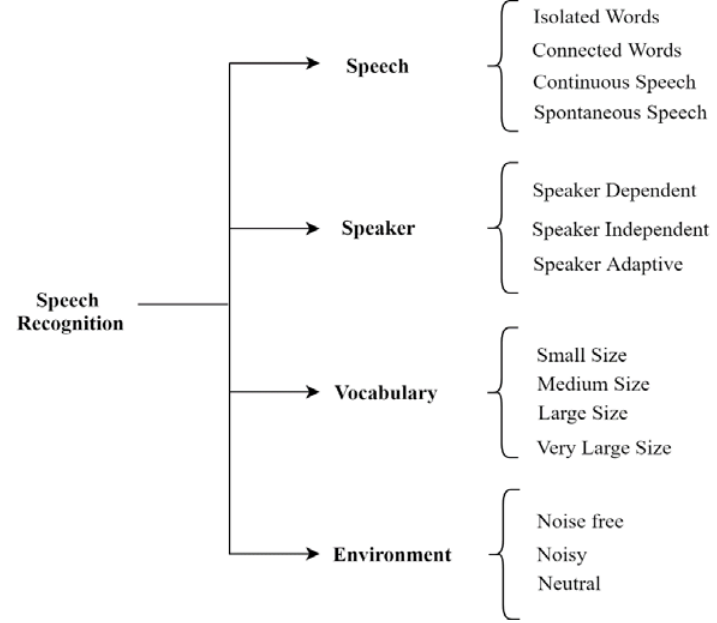
Figure 2. ASR system categories.